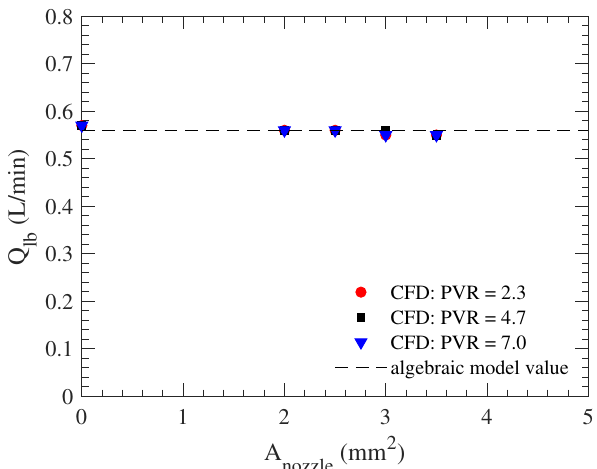
Figure 6. Lower body average flow rate, Q lb , obtained from CFD simulations with PVRs of 2.3 (red circle), 4.7 (black square), and 7.0 (blue triangle) Wood units-m 2 . Some data points are not clearly visible since they are overlapping. The dotted line is the constant lower body flow rate assumed in the algebraic